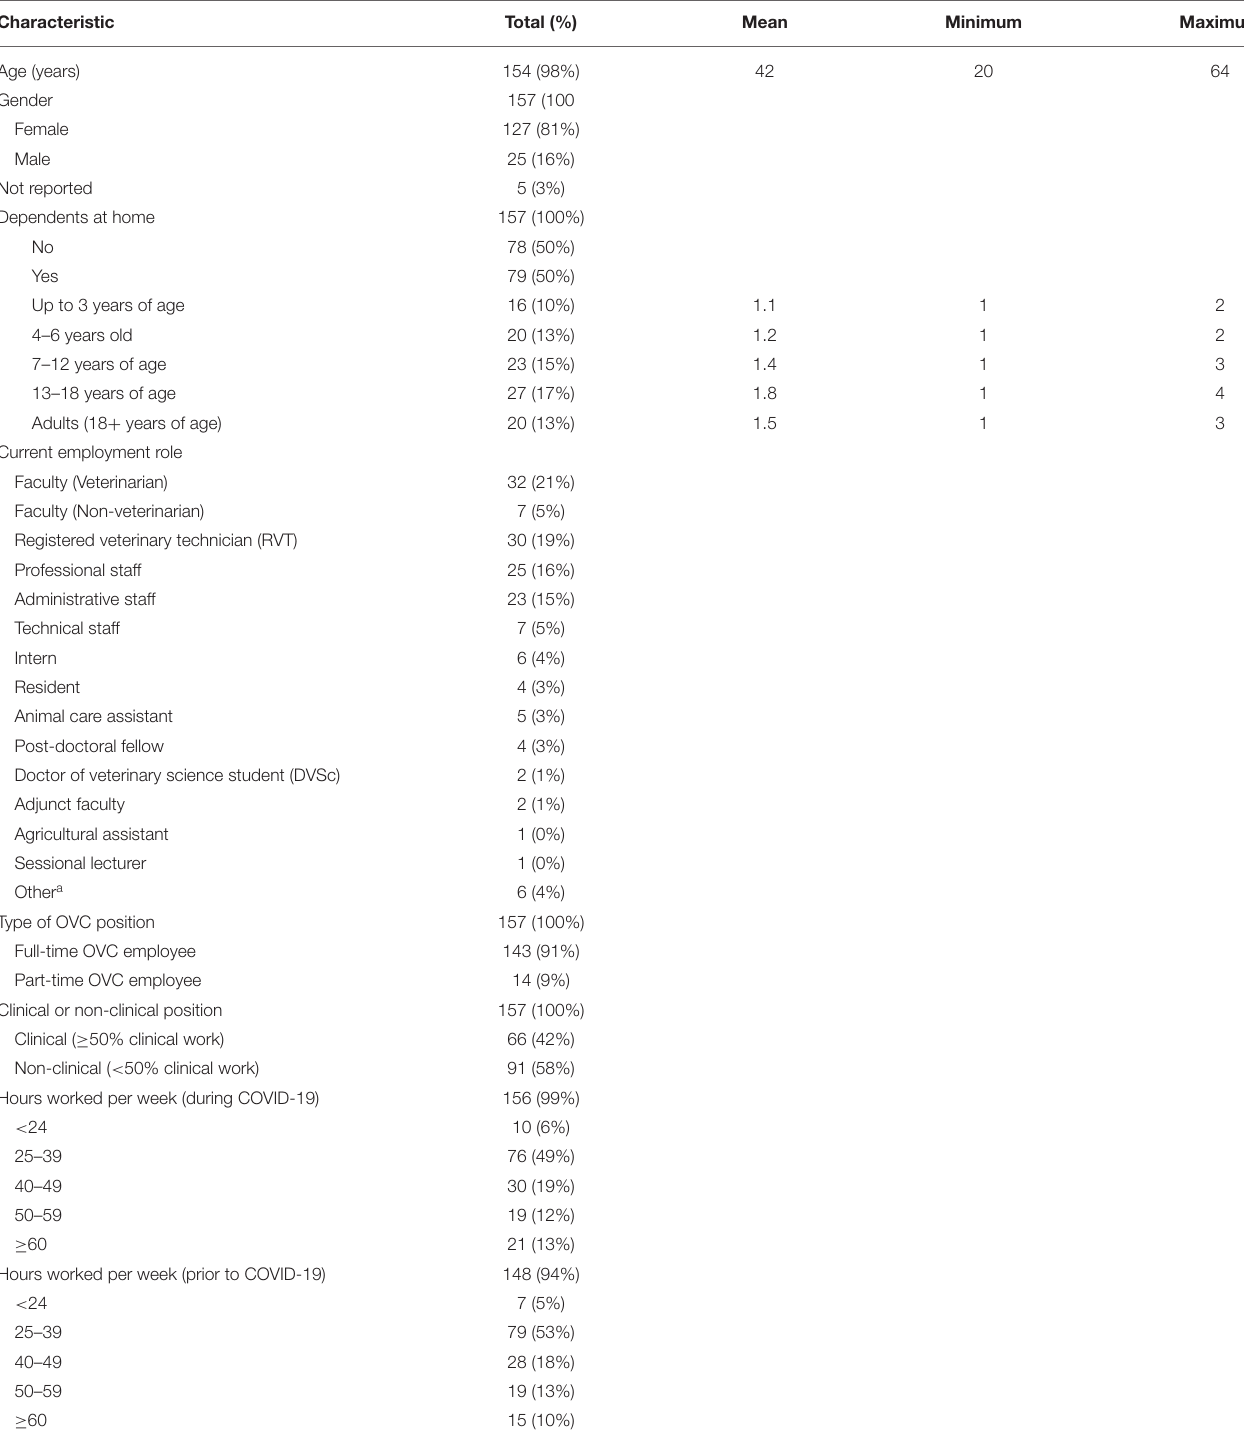
TABLE 2 | Demographic and career characteristics of study respondents (November 2020–January